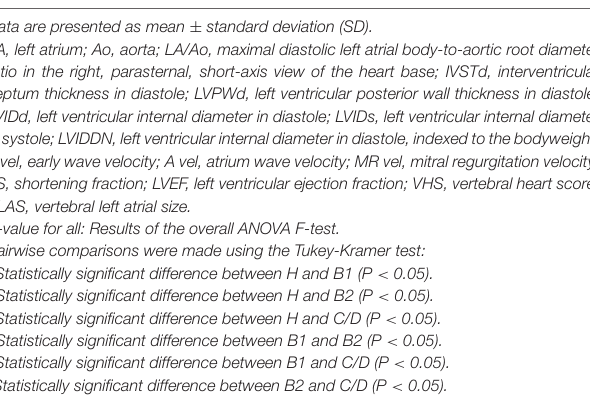
(furosemide: 1.1 ± 0.6 mg/kg/day) had no history of heart failure and, were being prescribed for cough reduction. Nine patients in Group C/D were receiving loop diuretics (torasemide: 0.33 ± 0.23 mg/kg/day).